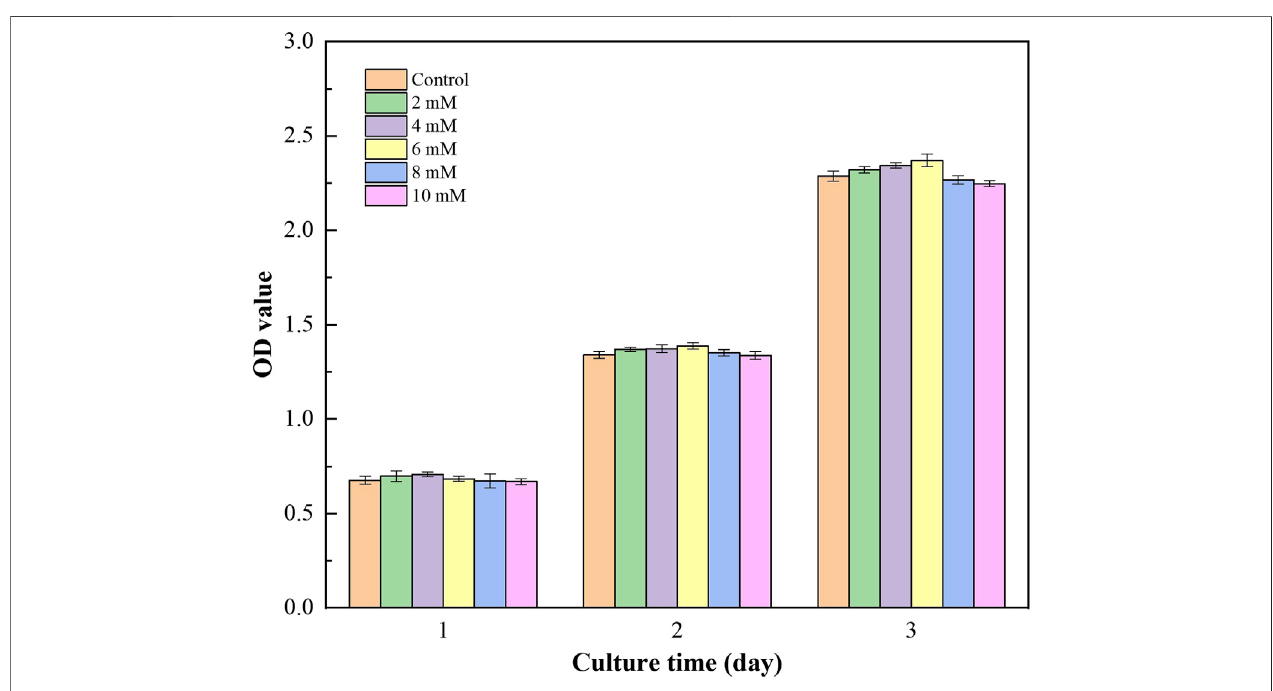
FIGURE 7 | OD value of MC3T3-E1 cells cultured with gradient Mg 2+ concentrations.